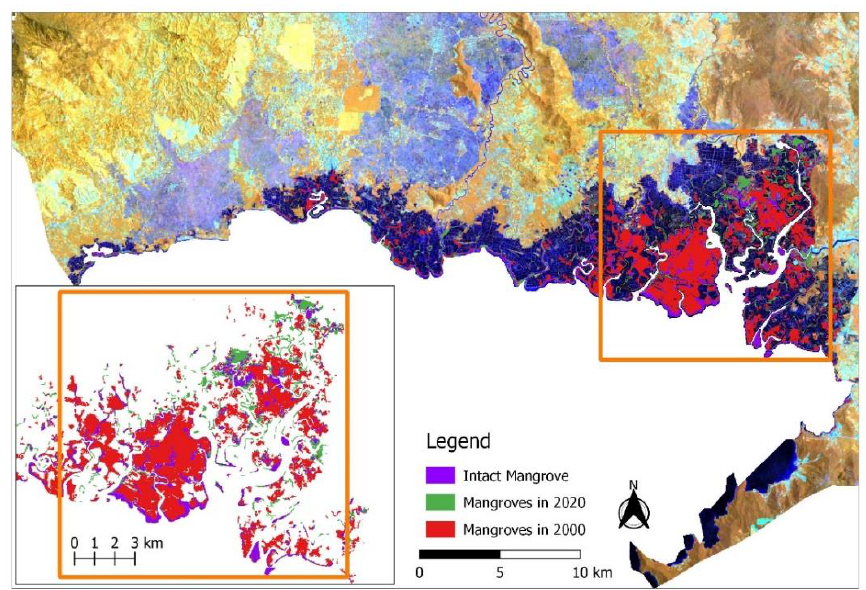
Figure 8. Intact and loss mangrove map from 2000 until 2020. Intact mangrove is the mangrove area in 2000 and still intact in 2020, Mangroves in 2020 is the mangrove area that just existed in 2020, and Mangroves in 2000 is the mangrove areas that existed in 2000 then deforested in 2020.